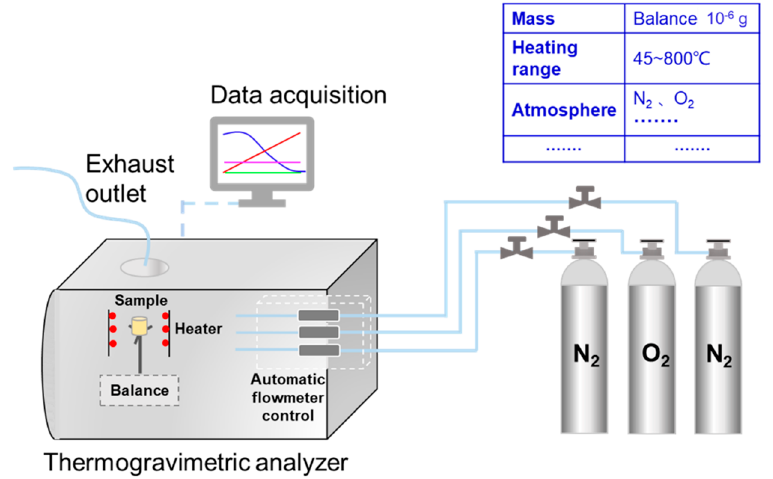
Figure 2. The schematic diagram of TG209F3.